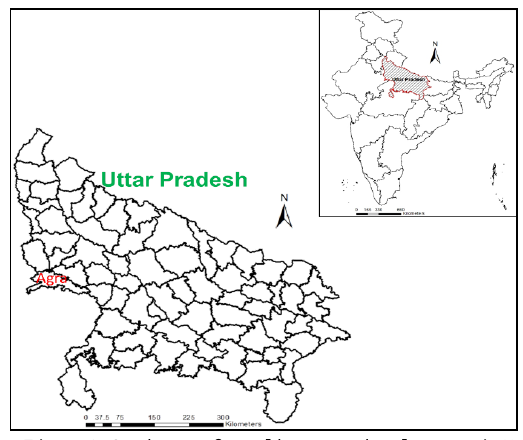
Figure 1. Study area for cold storage development in Uttar